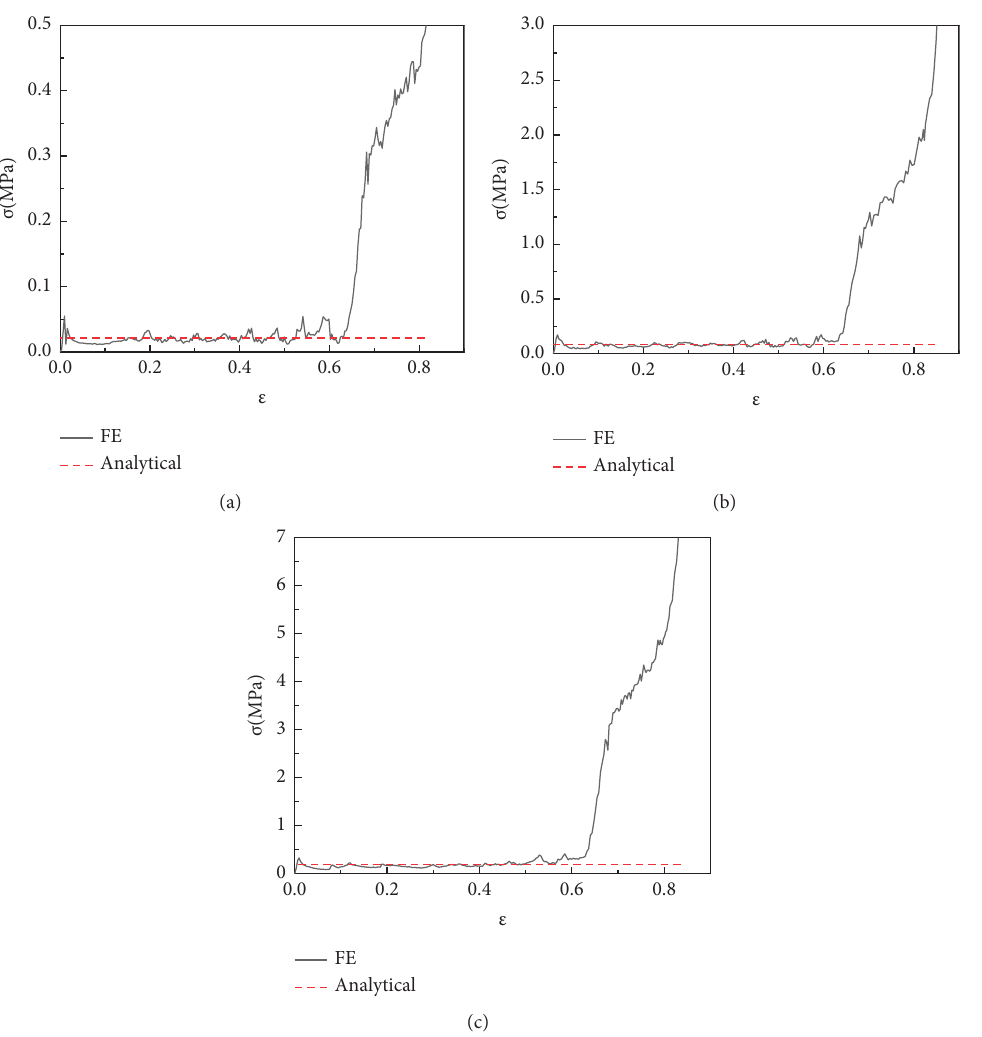
Figure 7: FE prediction of the quasi-static collapse response of DHHs with different relative densities, N � 12. (a) ρ � 2 . 5%. (b) ρ � 5%. (c) ρ � 7 . 5%. The direction of impact is x